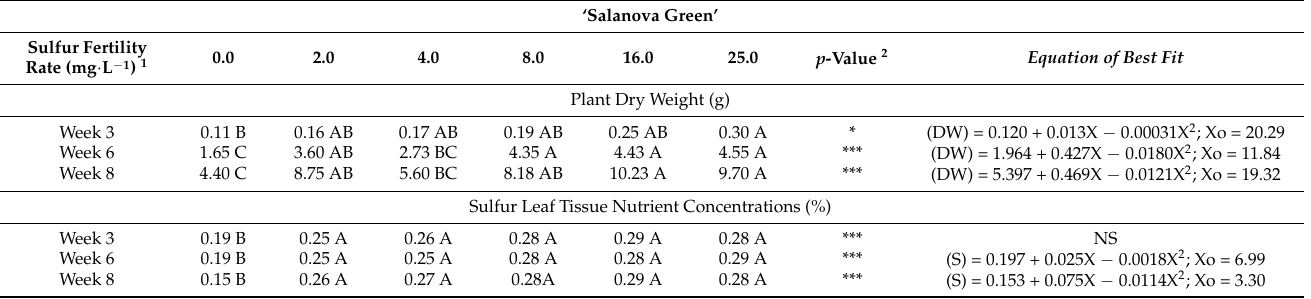
Table 6. Impact of sulfur fertility rate on plant dry weight and sulfur leaf tissue concentration on ‘Salanova Green’ lettuce. ‘Salanova Green’